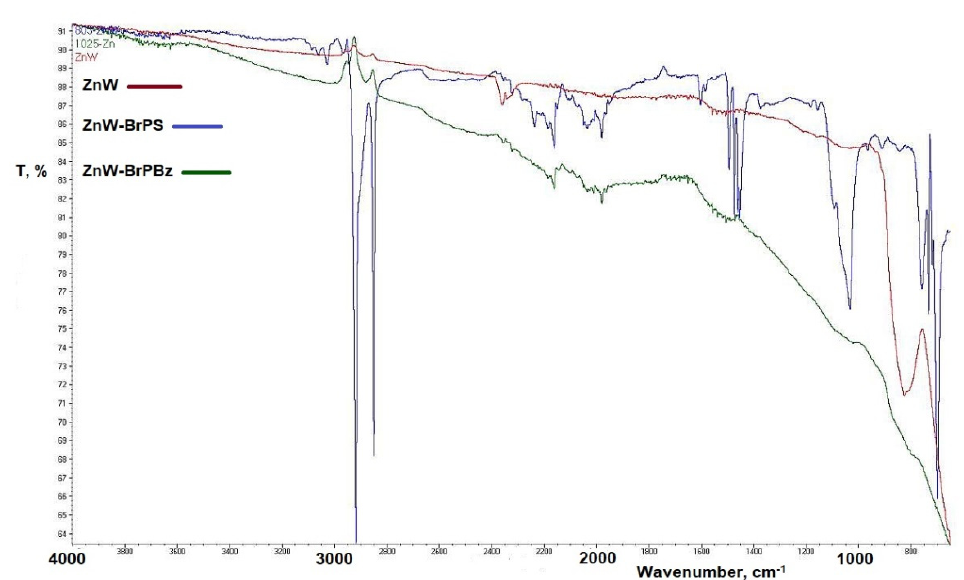
Figure 8. FTIR char spectra as percentage transmission (T%) derived from ZnW, ZnW-BrPS and ZnW-BrPBz formulation chars. ZnW = zinc tungstate; BrPS = brominated polystyrene; BrPBz = poly(pentabromobenzyl acrylate).